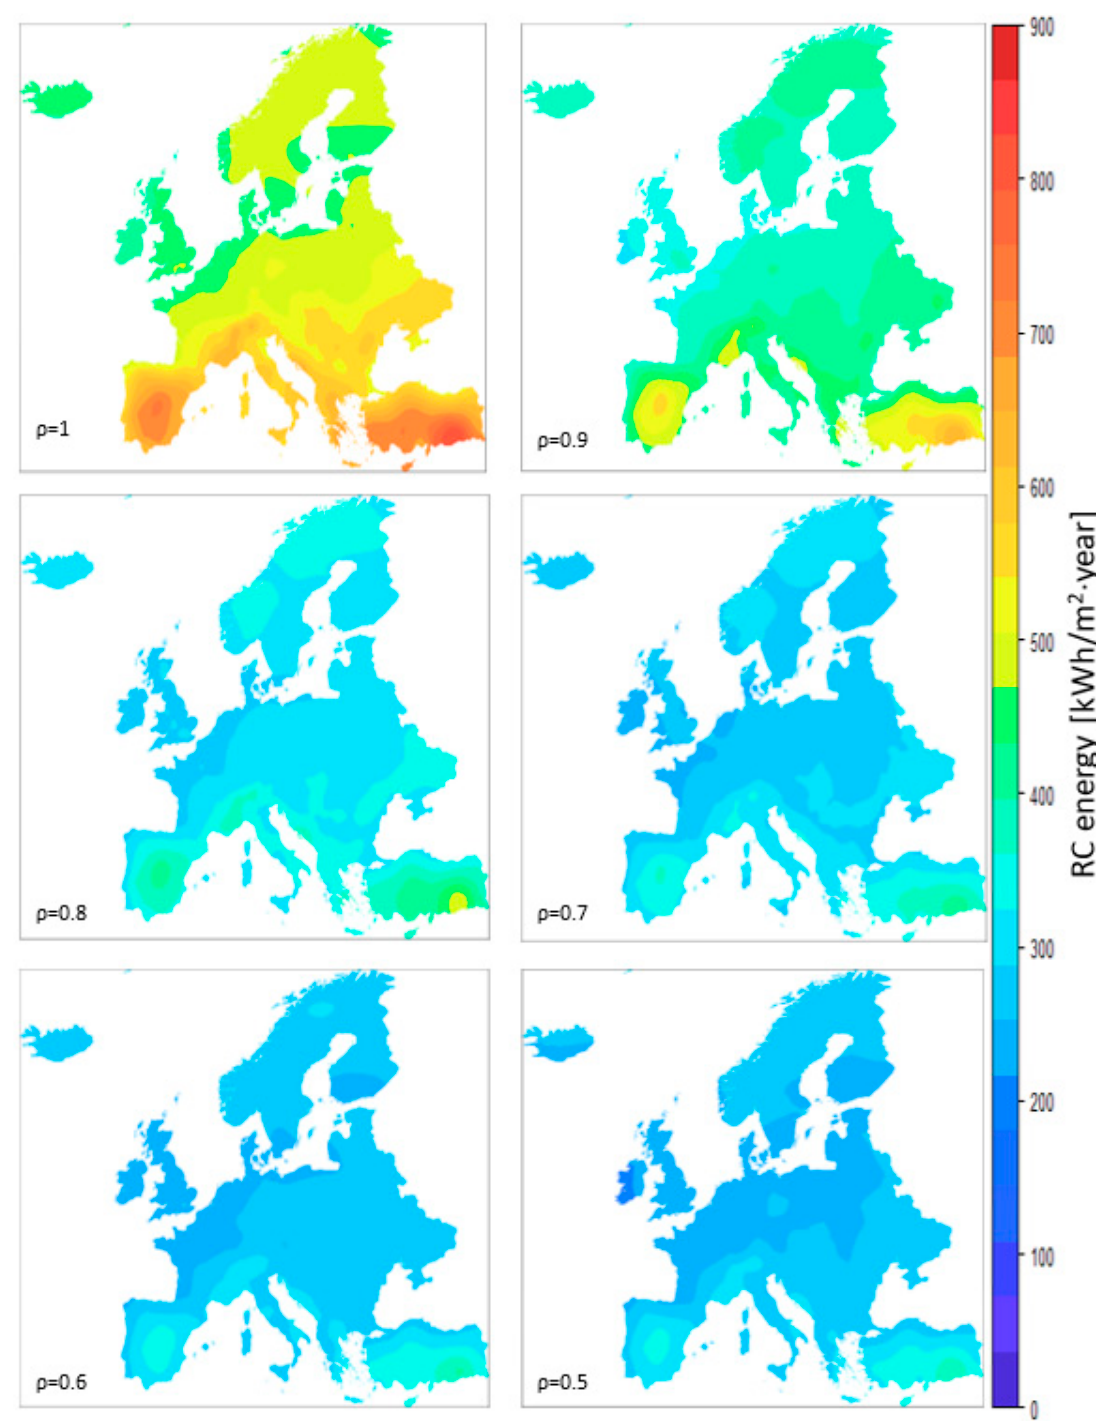
Figure 7. Map of annual RC energy (kWh/m 2 ·year) for six values of solar radiation reflectivity. Southern countries were more affected by the reduction of 𝜌 than northern and cen- tral countries: differences in the average RC energy available between 𝜌 = 1 and 𝜌 = 0.5 were 333.63 kWh/m 2 ·year in southern regions, 259.42 kWh/m 2 ·year in central regions and 217.49 kWh/m 2 ·year in northern regions. The model presented a good performance in the six cases (Table 9).